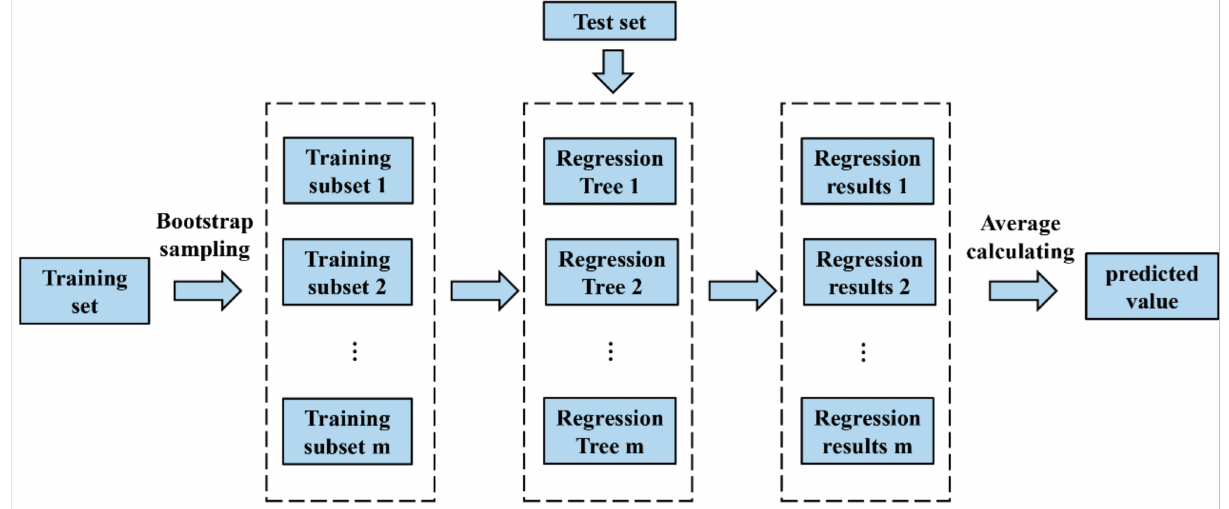
Figure 5. Construction of the random forest (RF) model and flowchart of leaf nitrogen accumulation (LNA) and leaf nitrogen content (LNC)